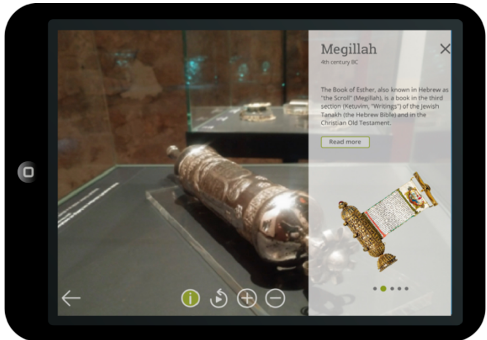
Figure 1. Screenshot of the e-Tracer Augmented Reality (AR) user interface (user’s view).